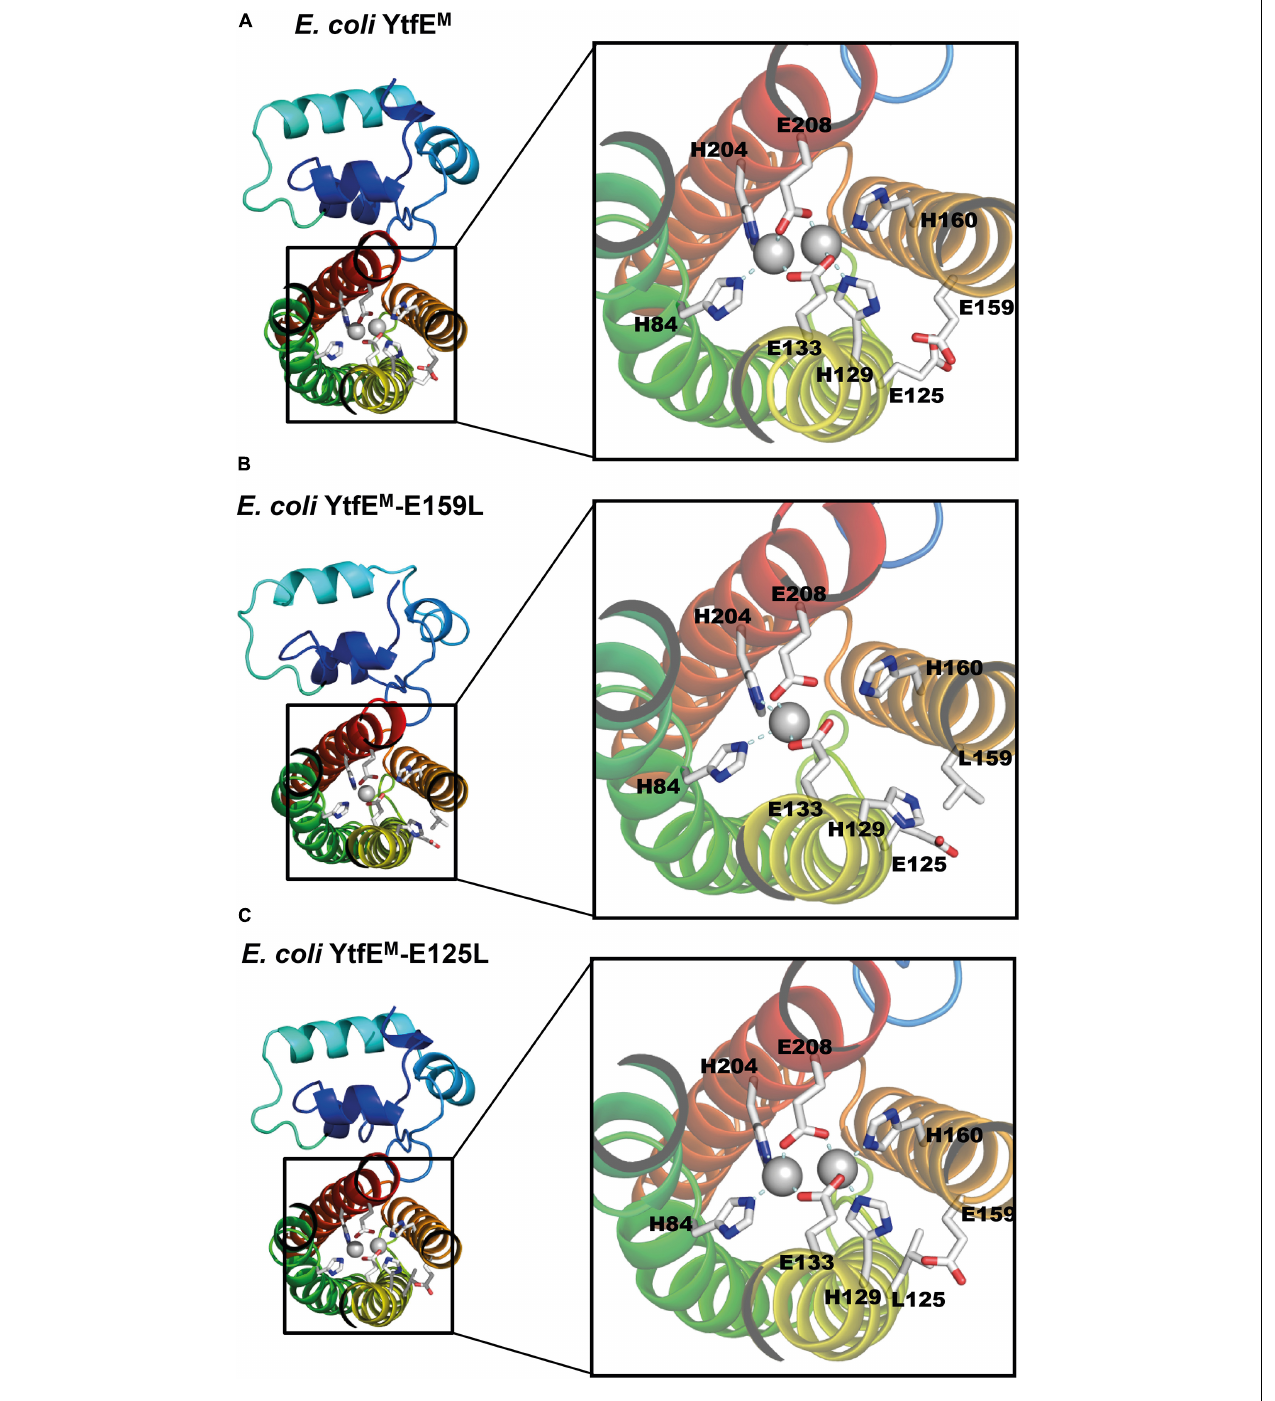
FIGURE 4 | E. coli YtfE Iron center. (A) YtfE M di-iron center is coordinated by residues H84, H129, E133, H160, H204, and E208. (B) YtfE M -E159L mononuclear Fe center is coordinated by H84, H204 and E208. The second Fe atom is not present and residue H129 assumes a different side chain conformation from that in YtfE M . (C) In YtfE M -E125L the di-iron center, is structurally similar to in YtfE M .